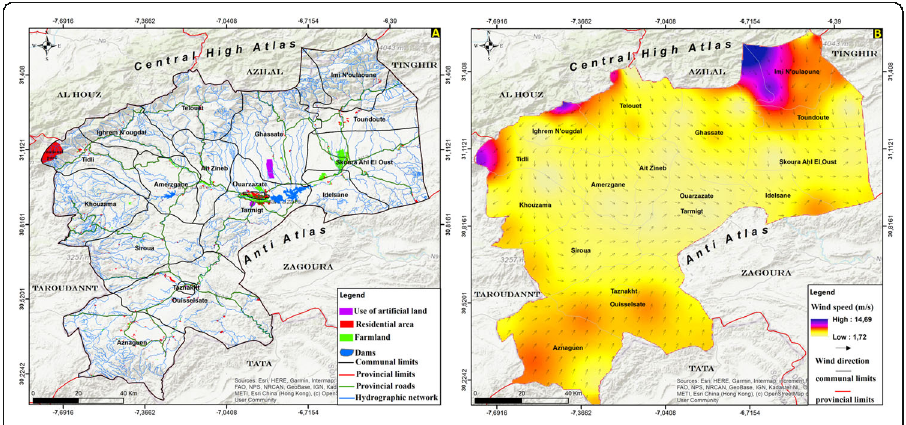
Fig. 8 Land-use map of the study area ( A ). Map of wind direction and speed in the study area ( B ) Standardization Each criteria map has a measurement range and a scale. The multi-criteria analysis and evaluation must match the measurement scale. The criteria standardization process can be used to match the measurement scales and convert them to comparable units. The analytical hierarchy process method can be used to normalize the data. For example, it organizes all map layer values into classes as desired by the decision maker (Table 3). Table 3 Suitability scores of the selected criteria Criteria Subcriteria Highly Moderately Less suitable Much less suitable suitable suitable Socio-